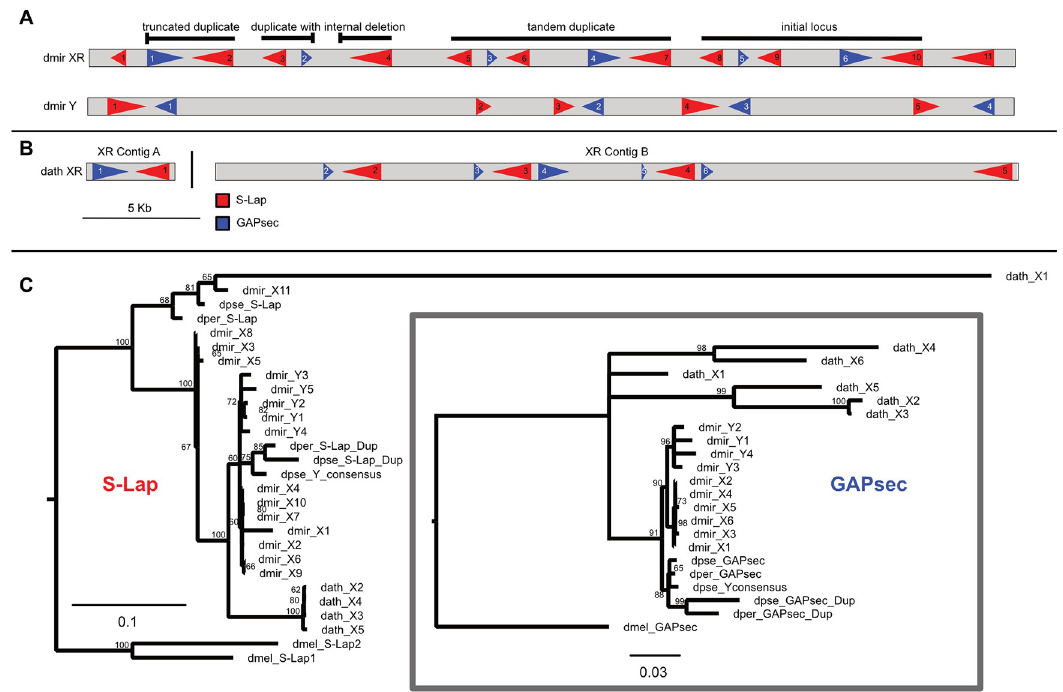
Fig 5. Independent amplification of S-Lap1 / GAPsec in different species of the obscura group. A . Genomic organization of S-Lap1 (red) and GAPsec (blue) genes on the X (dmir XR) and Y (dmir Y) chromosomes of D . miranda . We detect 11 copies of S-Lap1/2 and 6 copies of GAPsec on the X chromosome, and 5 copies of S-Lap1/2 and 4 copies of GAPsec on the Y chromosome of D . miranda . B . Genomic organization of S-Lap1 and GAPsec genes on the X (dath XR) of D . athabasca . We detect 5 copies of S-Lap1/2 and 6 copies of GAPsec on the X chromosome of D . athabasca . No assembly of the Y chromosome for D . athabasca exists. The location and orientation of each gene is represented by a single arrowhead. The arrowhead numbers correspond to the gene copy names in the gene trees. C . Gene trees of S-Lap1 and GAPsec copies of D . miranda and D . athabasca . RAxML maximum likelihood phylogenies were inferred from multiple sequence alignments of the gene copies shown in (A) and (B). Nodes with bootstrap support values less than 50 are collapsed. Alignments used to generate the trees shown in Fig 4C are provided as S6 and S7